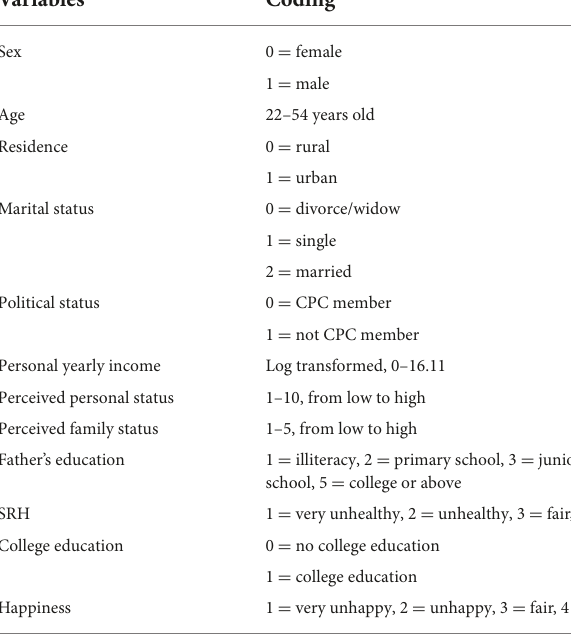
TABLE 1 Descriptive information of variables, N =